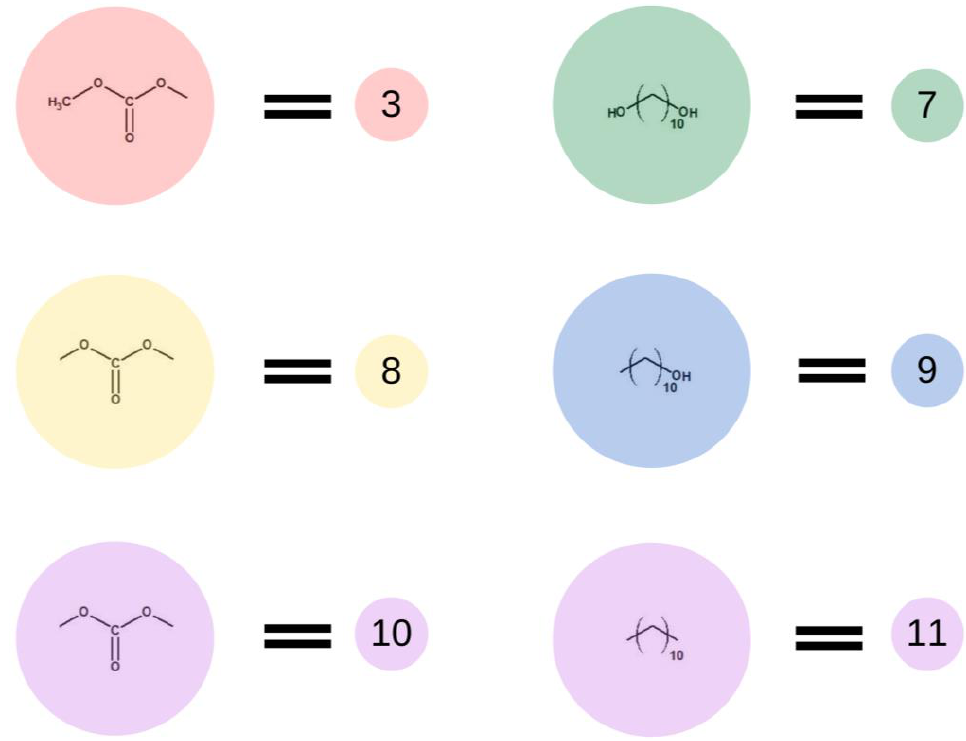
Figure 4. Schematic representation of the base units used in the second stage of the simulation.